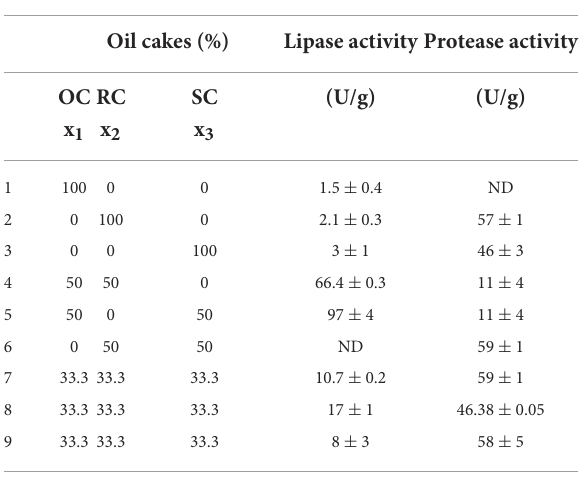
TABLE 2 Substrate composition for each run of SSF experiments and results of the dependent variables studied in simplex centroid design. Runs Independent variables